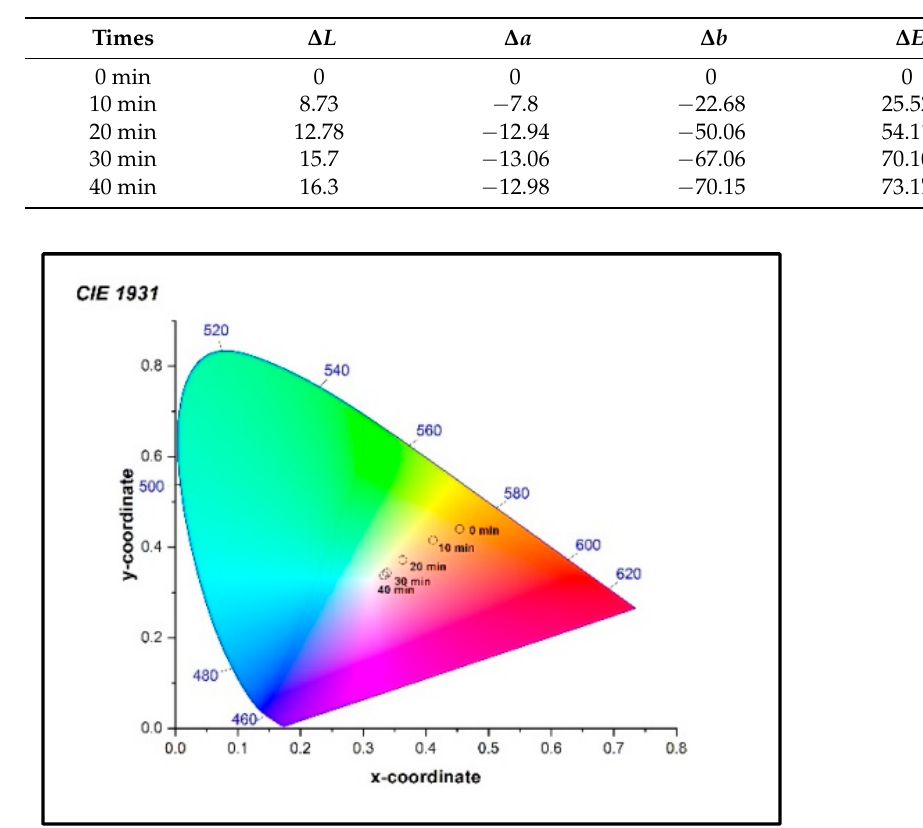
Figure 5. The CIE chromaticity diagram for photocatalytic degradation of MO using Gd 2 O 3 -ZIF-8 nanocomposites.